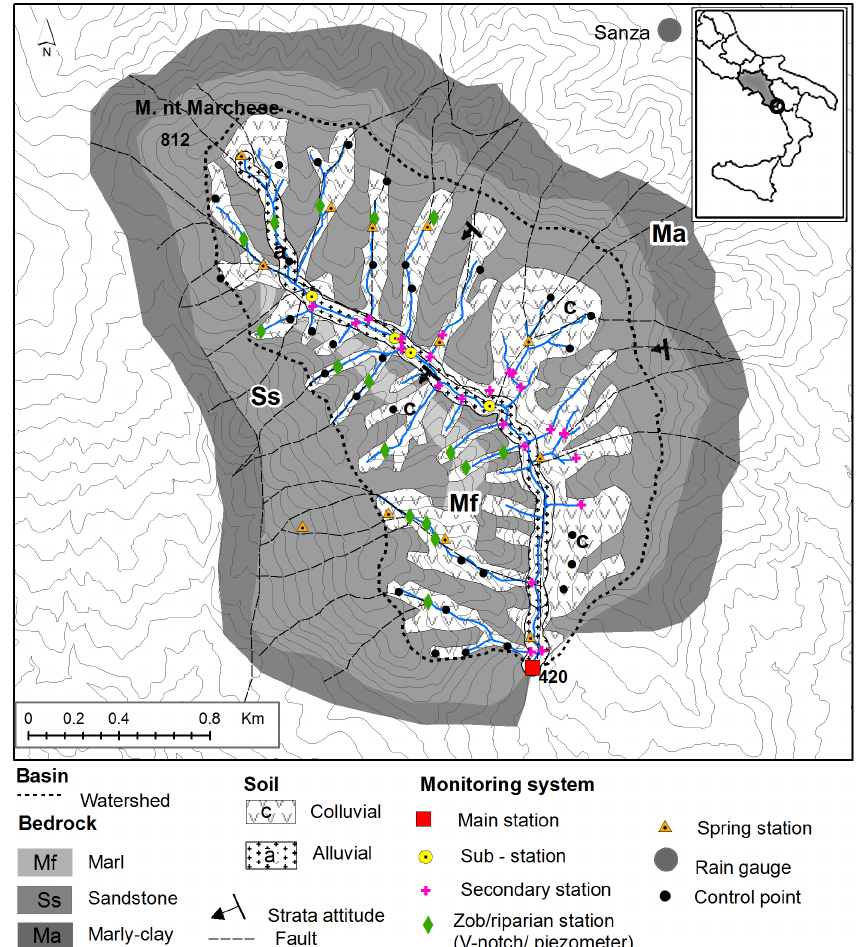
Figure 1. Hydrogeological map of the Ciciriello Experimental Catchment and location of the monitoring stations (modified from Cuomo and Guida, 2016). Legend: bedrock lithology: Ma, marly clay and argillite Tertiary formation, and base aquiclude; Ss, sandstone Miocene formation, and fractured general aquifer; Mf, marl, interlayered and perched